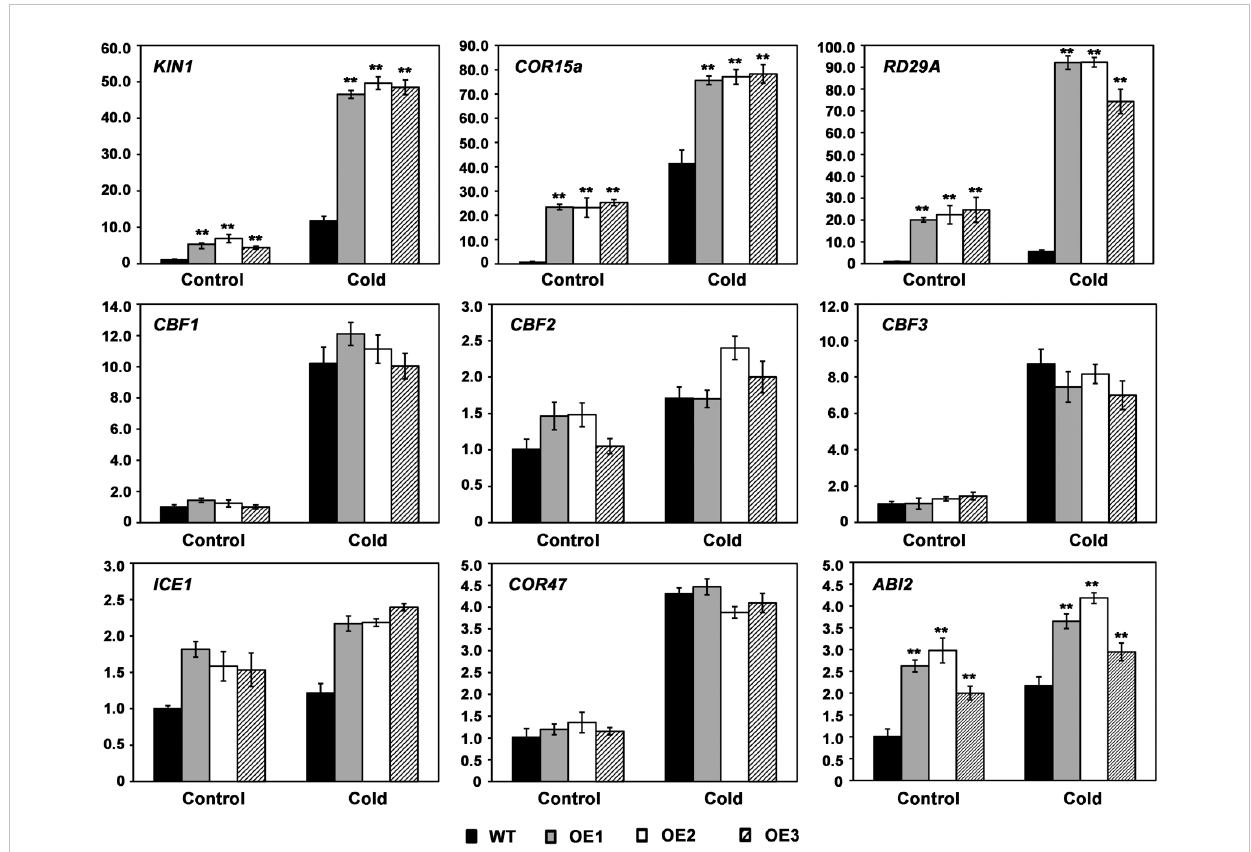
FIGURE 5 Expression patterns of stress responsive marker genes in wild-type and transgenic Arabidopsis using real-time PCR. Total RNA was extracted from 14-d-old plants grown under normal or cold treatment for 6 h. Arabidopsis Actin2 was used as an internal control. Data represent means from three biological and three technical replicates, each containing three seedlings of each line. Error bars indicate SD. Asterisks indicate a signi fi cant difference from the wild type (WT): **, P<0.01 ( t